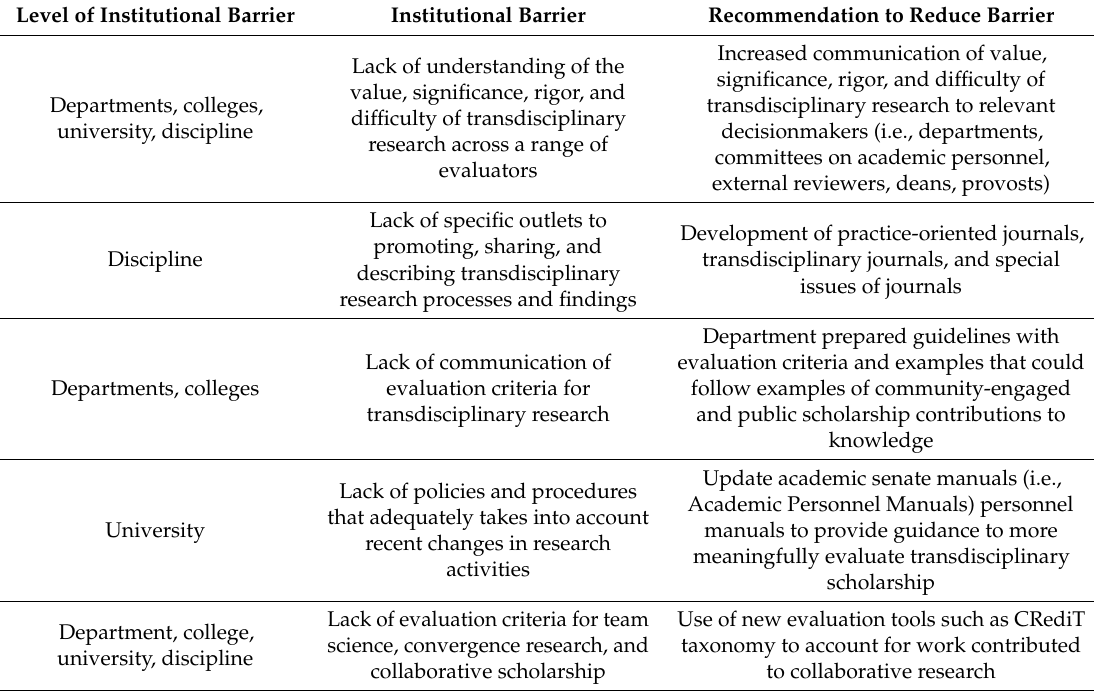
Table 3. Summary of institutional barriers to doing transdisciplinary research with recommendations to reduce these